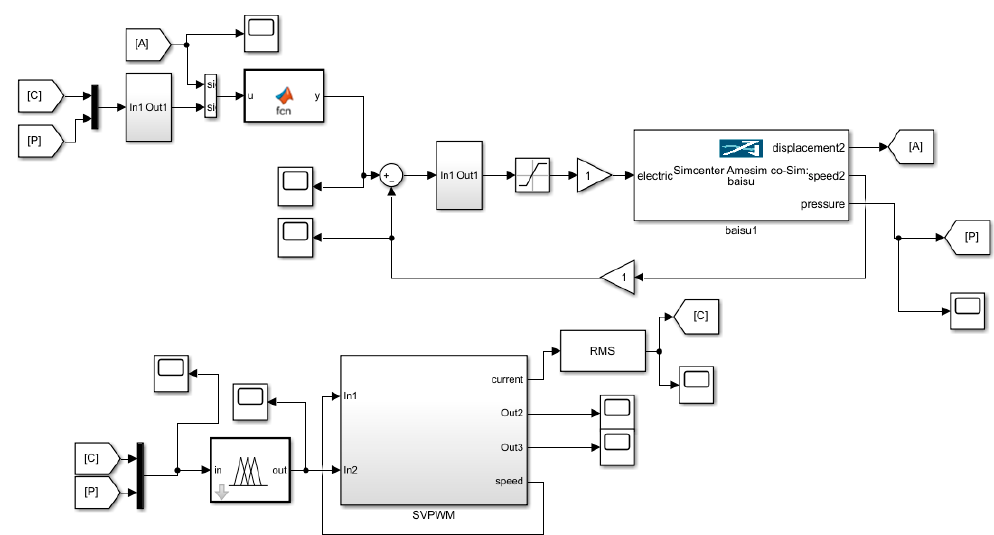
Figure 14. Co-simulation model of hydraulic system and electrical system.